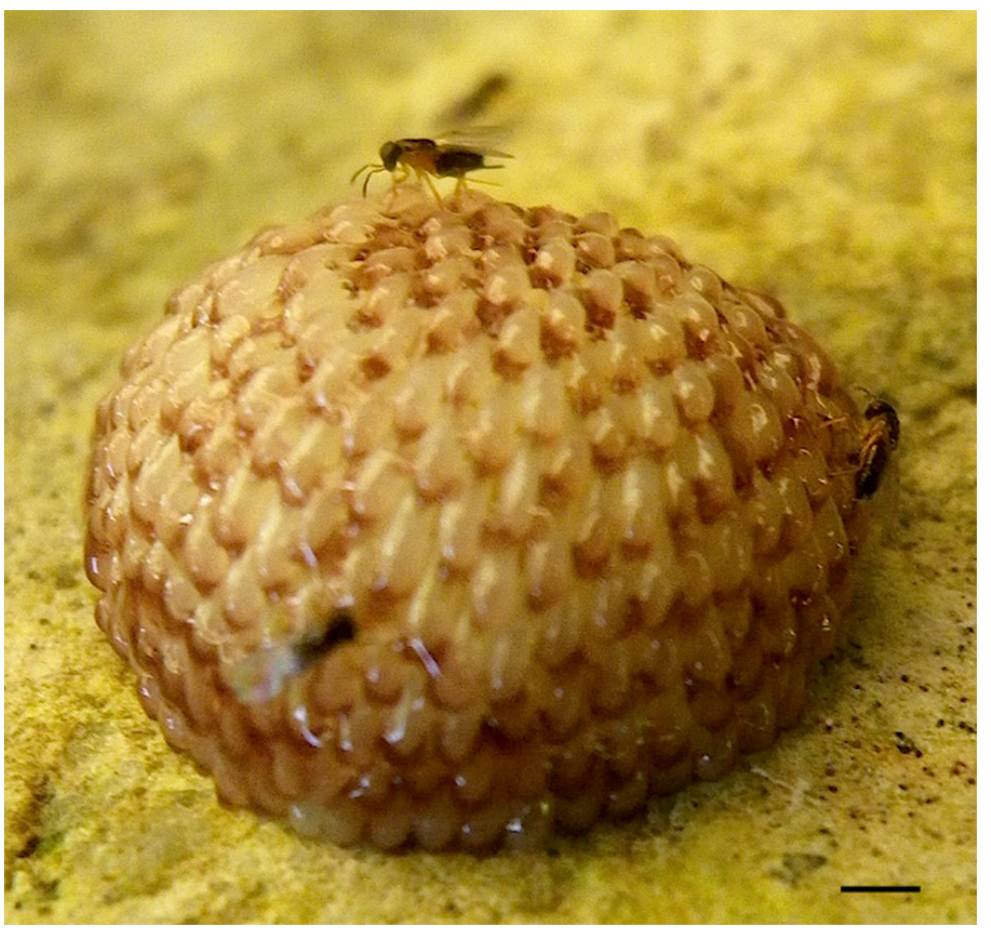
Figure 7. Three females of the egg parasitoid Ooencyrtus yoshidai on the multi-layered egg mass with a sticky cover secreted from the female accessory glands of Protohermes grandis . Scale bar: 1 mm.